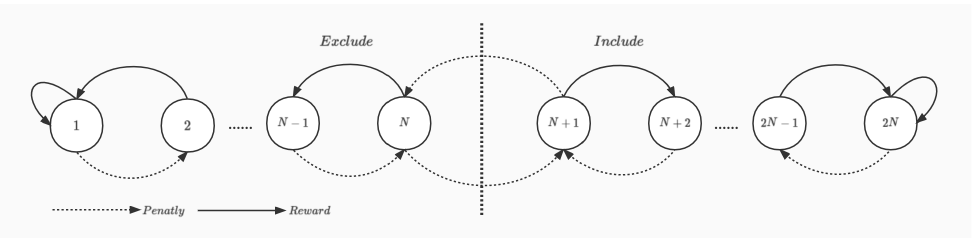
Figure 3. Two Actions and Transition of